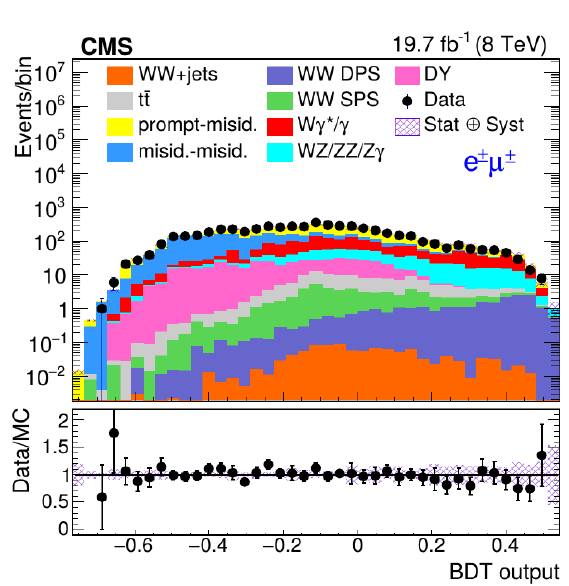
Figure 8. The average number of charged particles as function of the leading jet p T in proton-proton collisions at 13TeV, see Ref. [11]. Shown here is the “transMIN” region, which is trans- verse to the leading jet and in the hemisphere with less activity.